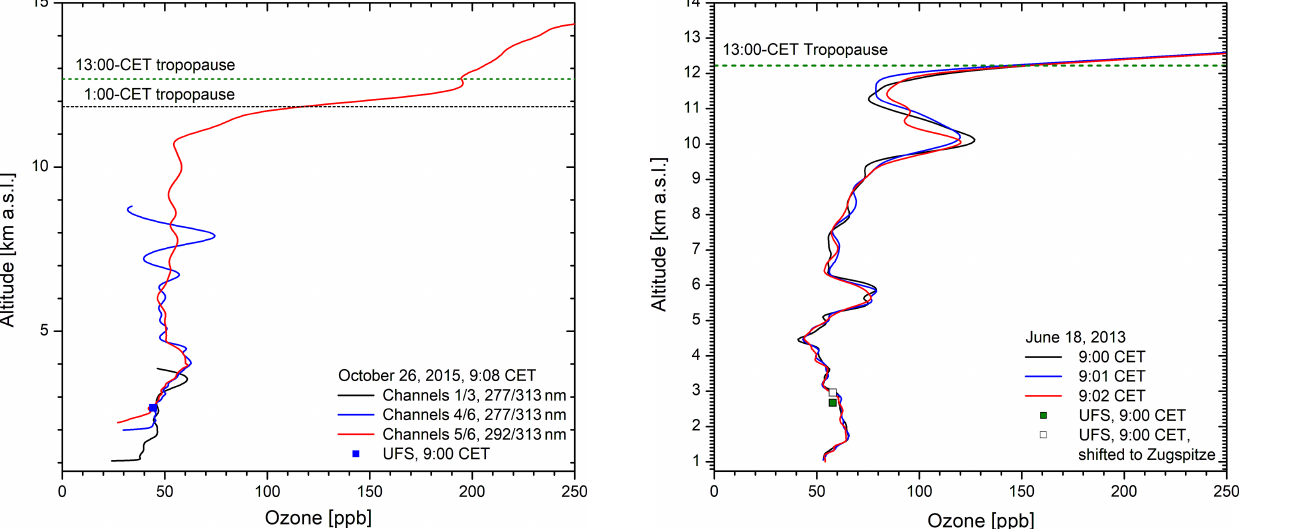
Figure 16. Example for reproducibility testing during a period of elevated ozone: the on wavelengths used are 277nm (channel 1, near-field telescope, up to 2.23km), 277nm (channel 6, up to about 6km), and 292nm (channel 5, up to the top). The lidar measure- ment perfectly agrees with that at UFS if the altitude is shifted to that of the Zugspitze summit (2962m), justified by the southerly advection. Above 5km the signal in channel 6 becomes low due to the high ozone values in the lower troposphere, and a weighted aver- age of the 277–292nm ozone profile with that for 292–313nm was applied for the final few hundred metres below 6km. Above 9km the 292nm signal starts to become noisy, resulting in reduced repro- ducibility. The altitude of the tropopause is taken from the Munich